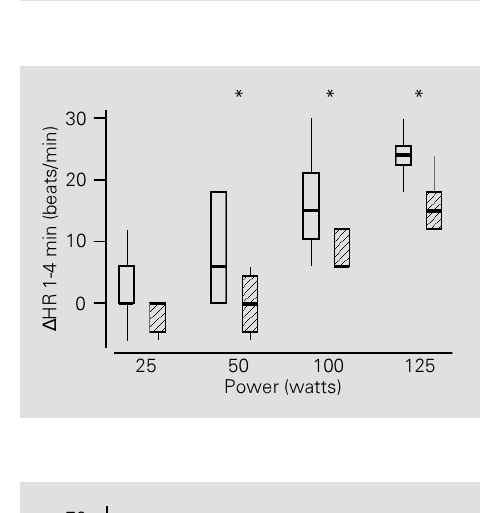
Figure 1 - Increases in HR ( D HR) during dynamic exercise at power values of 25, 50, 100 and 125 watts, in the 0-10-s interval ( D 0-10 s) in the sedentary (open boxes, N = 7) and trained (hatched boxes, N = 8) groups. The data are reported as medi- ans, quartiles (1st and 3rd) and minimum and maximum values. *P<0.05.